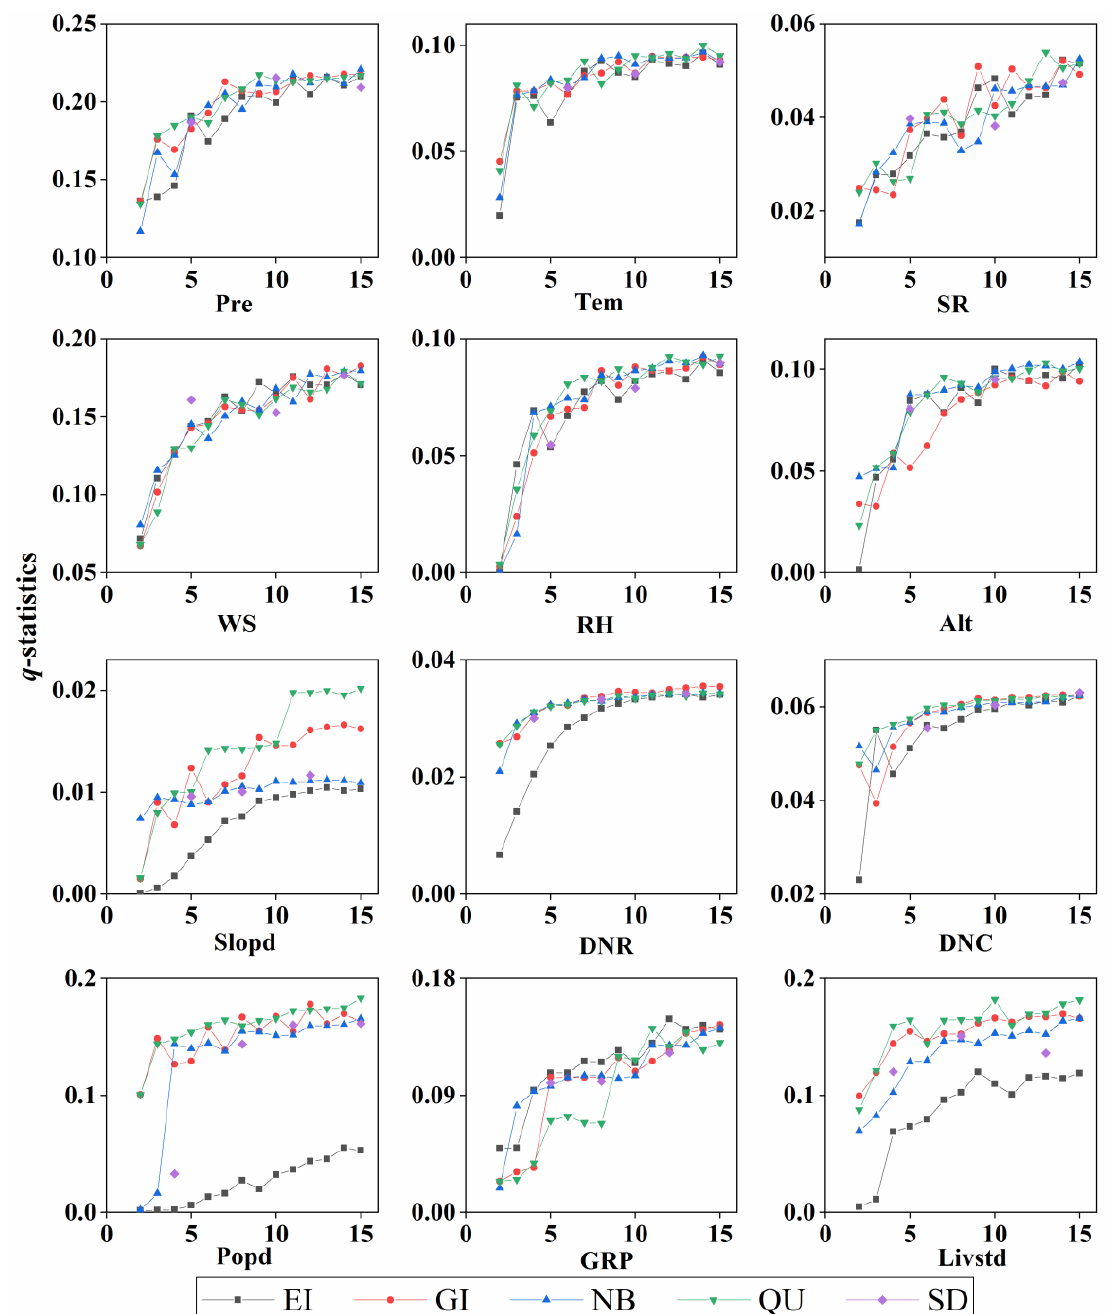
Figure 6. Comparison of the q -statistics under the different discretization methods and stratification number combinations. The five types of discretization methods include equal interval (EI), geometrical interval (GI), natural break (NB), quantile (QU), and standard deviation (SD). Pre: precipitation; Tem: air temperature; SR: solar radiation; WS: wind speed; RH: relative air humidity; Alt: altitude; Slopd: slope; DNR: distance to the nearest road; DNC: distance to the nearest county centers; Popd: population density; GRP: Per capita gross regional product; and Livstd: livestock density.